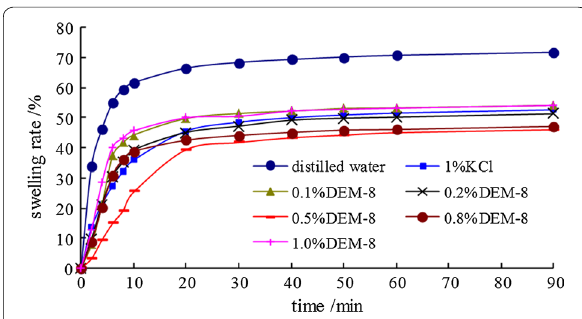
Fig. 1 The screening of the concentration of